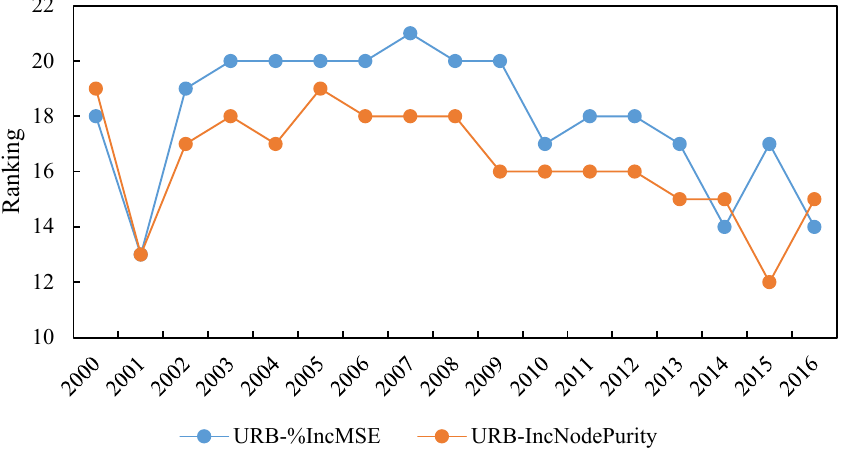
Figure 6. Rank change in importance of influence of urbanization rate on PM 2.5 concentration. URB refers to urbanization.